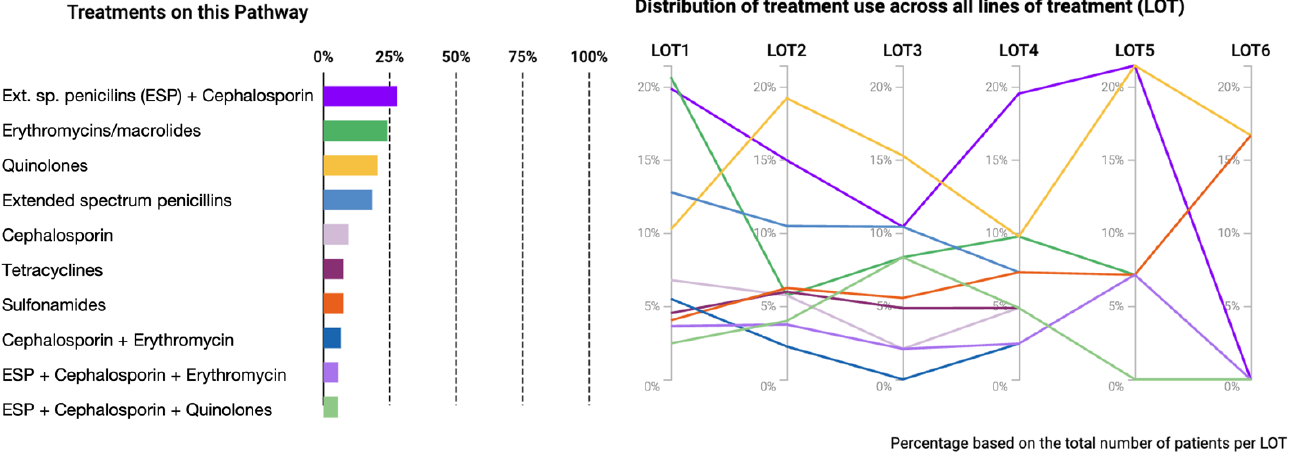
Figure 2. Treatment pathways for cohort 2 (with antibiotics). The left side shows the ten most administered treatments, and the right side shows six lines of treatment (LOT). Extended spectrum penicillins (ESPs).